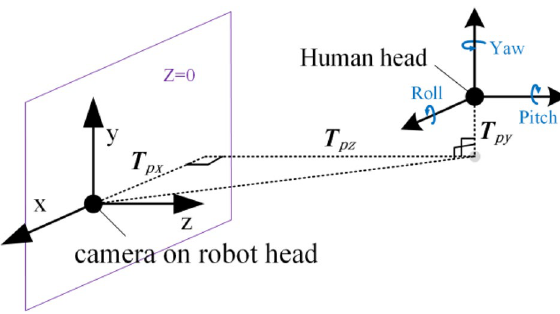
Figure 3. Head pose estimation in a camera coordinate